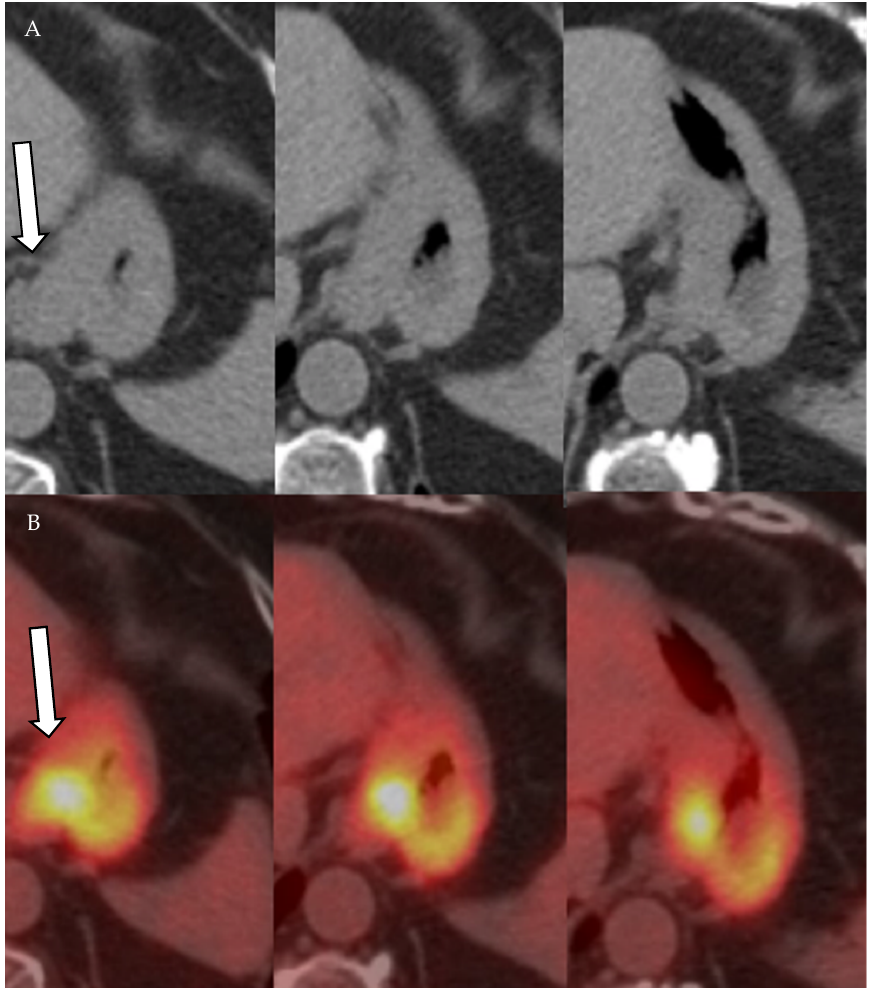
Figure 11. A 61-year-old female patient with history of gastric cancer. PET/CT scan demonstrates diffuse thickening of the gastro-esophageal region as well as the gastric cardia (arrow) ( A ) consistent with gastric carcinoma, which is FDG-avid (arrow) with maximum SUV = 11.6 ( B ). There is no focal abnormal metabolic activity to suggest distant metastatic spread or regional lymphadenopathy.